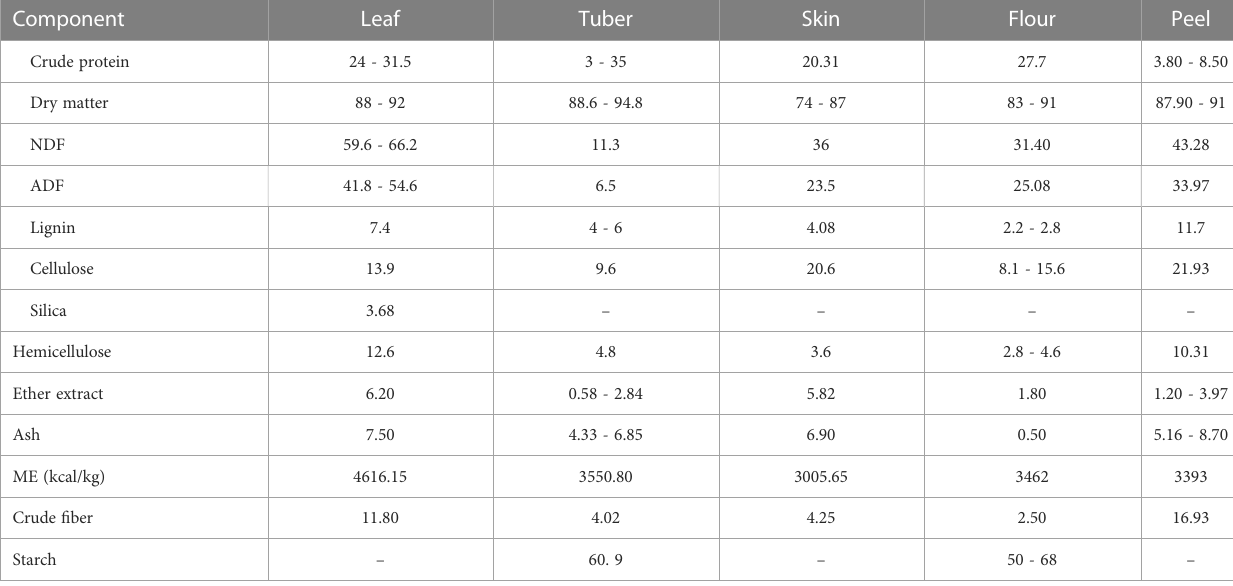
TABLE 5 Chemical compositions of the different parts of cassava (%, dry matter).